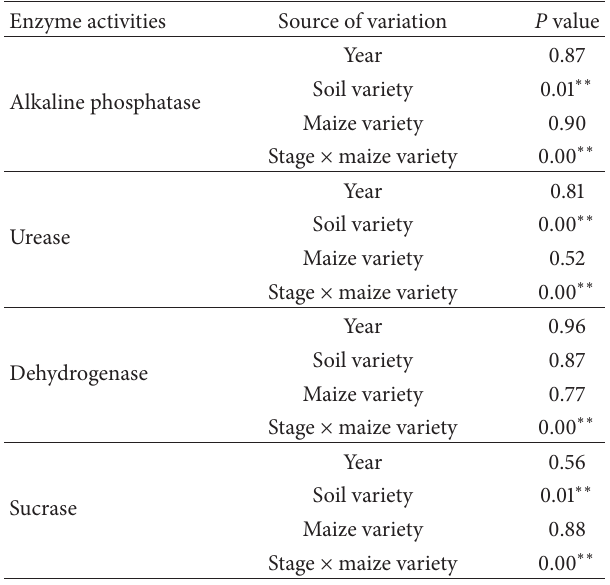
Table 4: ANOVA of four enzyme activities in rhizosphere soils. Enzyme